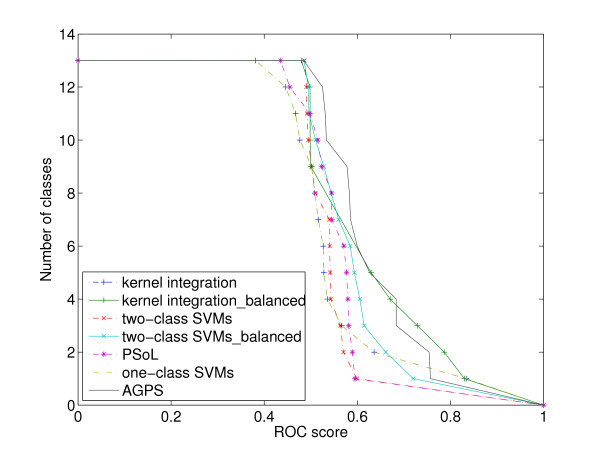
Comparison of the five methods class by class. Comparison of the performance among the five methods, where two-class SVMs_balanced means the results by two-class SVMs trained on balanced data and the same for kernel integration. The number of classes versus one ROC score threshold is countered, and a higher curve means a better result.